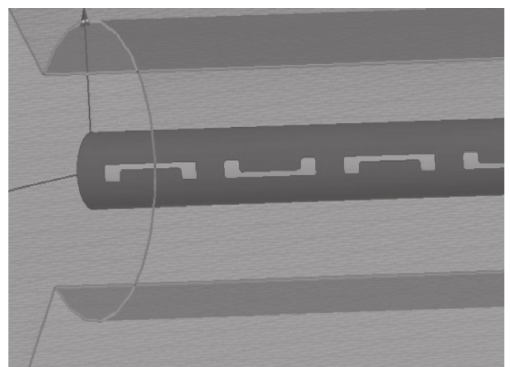
Figure 3: Schematic diagram of a U-groove leakage cable simulated groove.